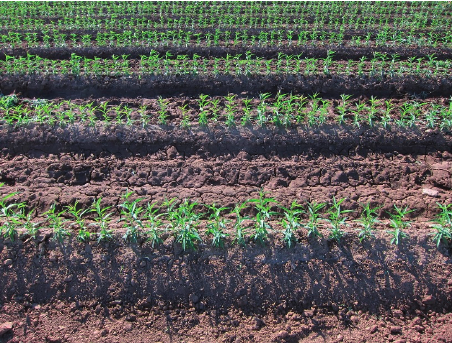
Figure 8. Sample image of rows for the purpose of counting multiple rows